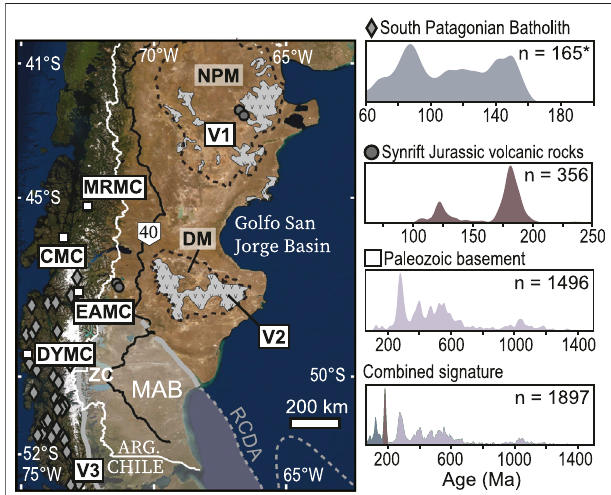
FIGURE 10 | Map of southern South America with traces of the Magallanes Austral basin (MAB) and proposed source locations. Individual markers correspond to sample locations compiled from other workers from Paleozoic metamorphic basement terranes (Herve et al., 2003; Hervé and Fanning, 2001; Herve et al., 2010), distal Jurassic terranes (Ghiglione et al., 2015; Navarro et al., 2015) and the South Patagonian Batholith (Herve et al., 2007). Resulting compilations are plotted as kernel density estimate plots both individually and as a combined signature. Zones of Jurassic silicic volcanic events are labeled as V1 (188 – 178 Ma), V2 (172 – 162 Ma), and V3 (157 – 142 Ma) (e.g., Pankhurst et al.,